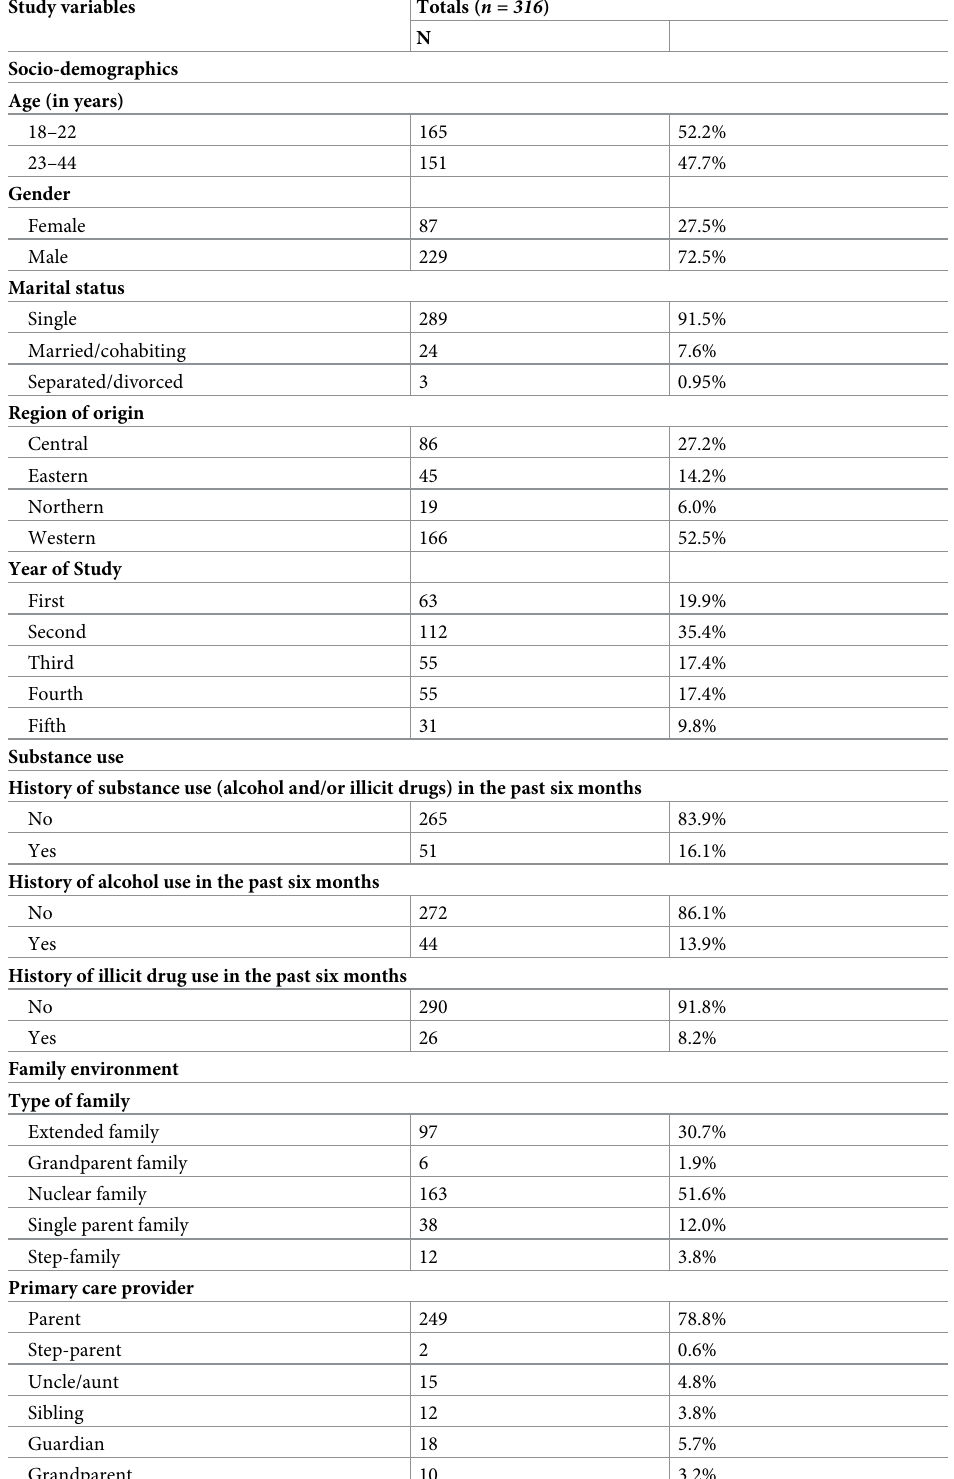
Table 1. Socio-demographics, sexual and family characteristics of